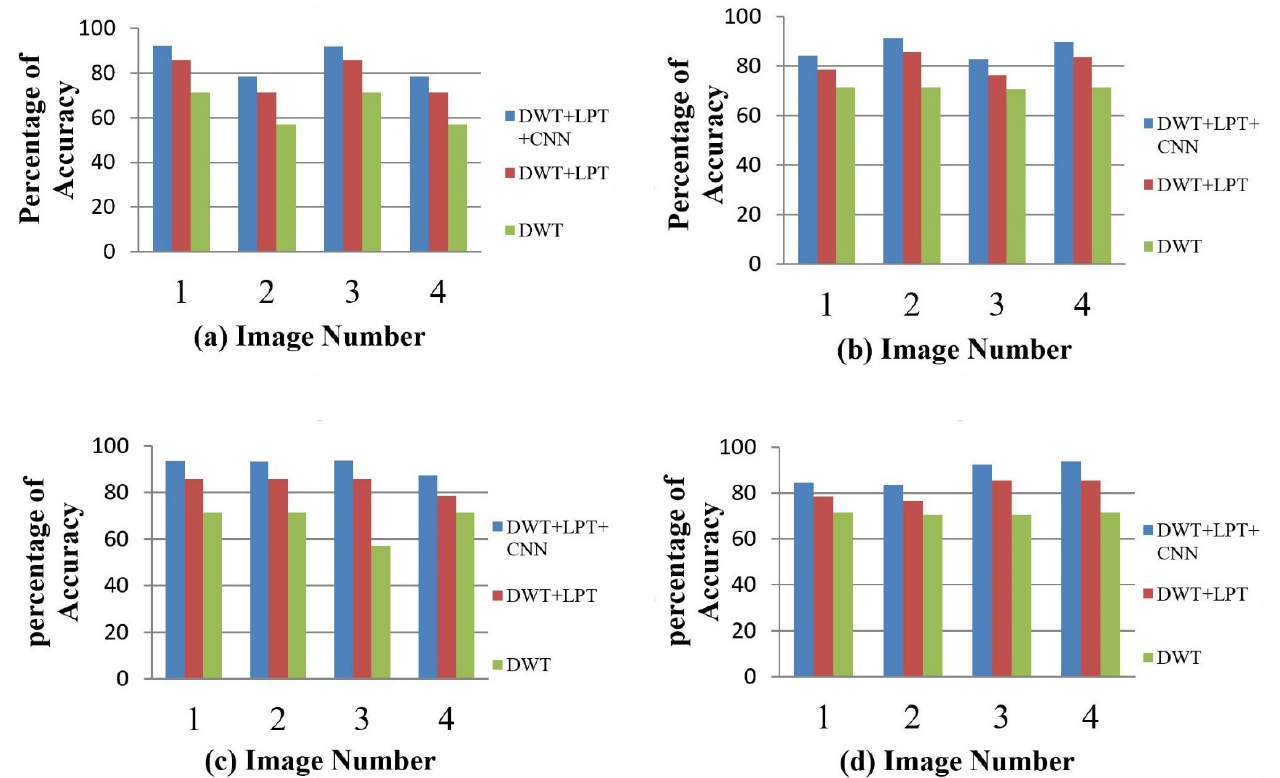
Figure 10. The percentage of accuracy versus image for distorted/simulated image: ( a ) RBF; ( b ) Linear ( c ) Polynomial; ( d ) Quadratic.